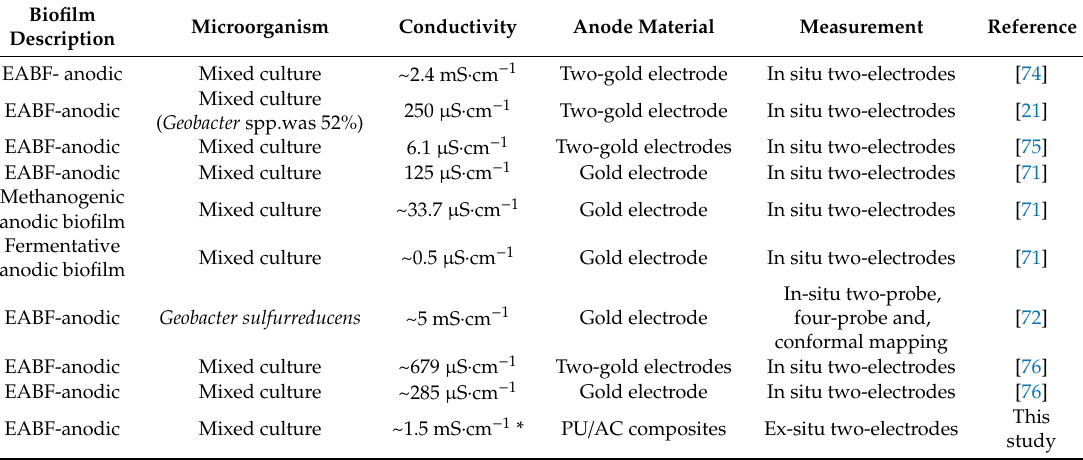
Table 2. Biofilm conductivities reported in the literature.